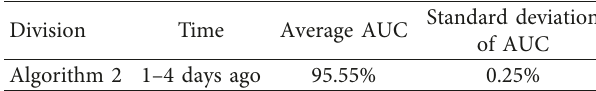
Table 6: Evaluation of repeat prediction performance of final